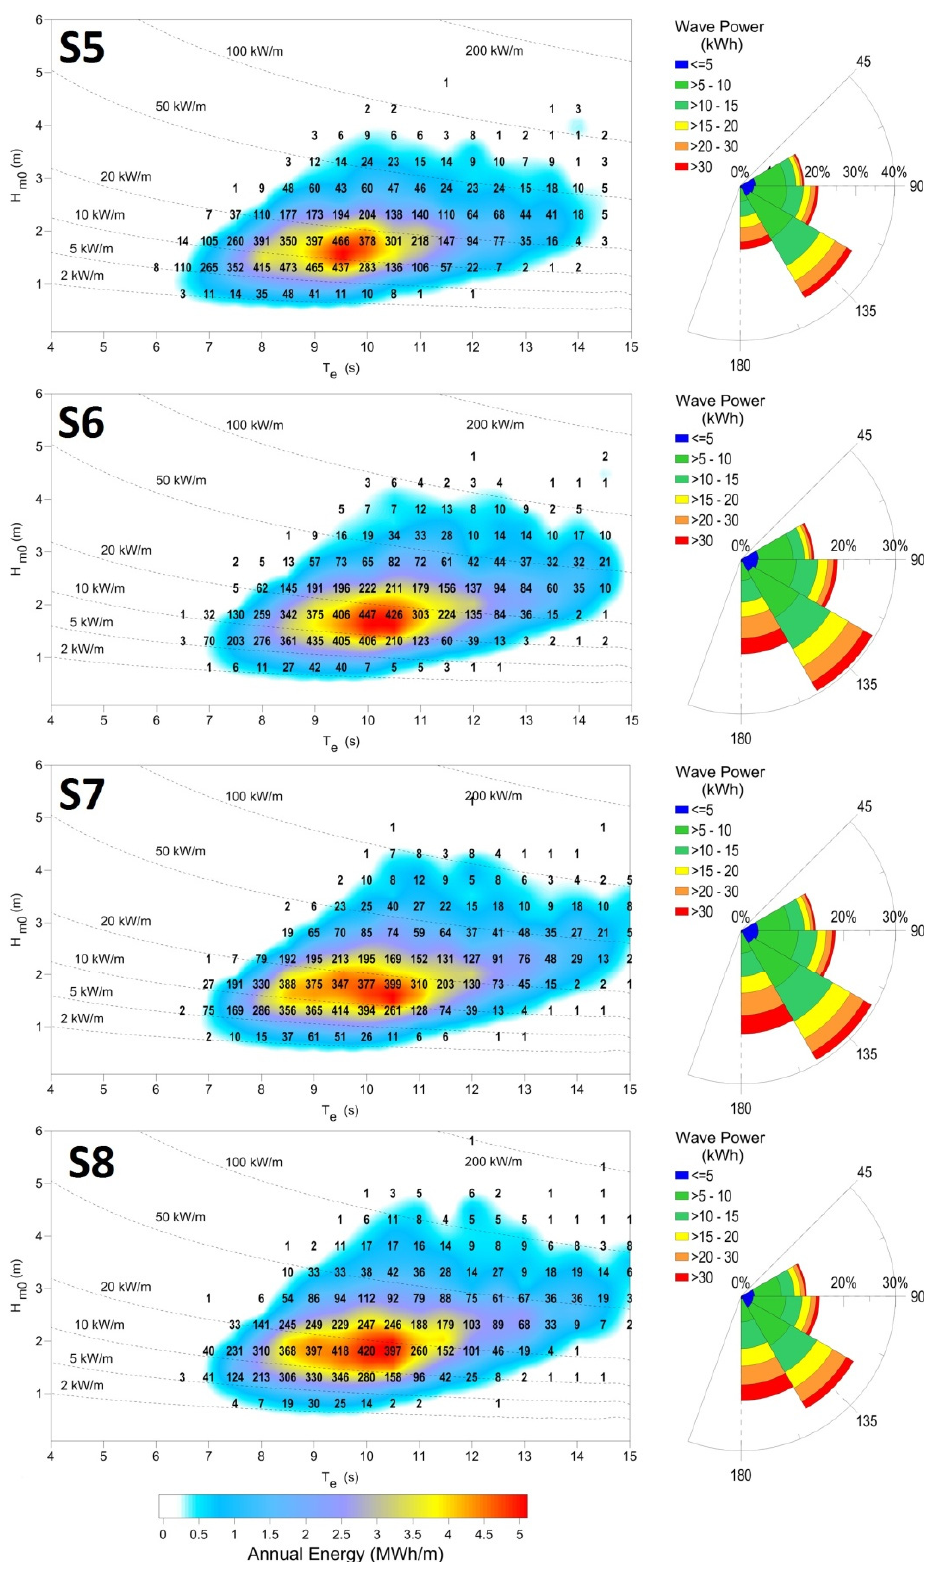
Figure 13. Characterization of the yearly average wave energy points S5, S6, S7, S8 in terms of significant wave height (H m0 ) and energy period (T e ). The color scale represents annual energy per meter of wave front (in MWh/m). The numbers within the graph indicate the occurrence of sea states (in number of hours per year) and the isolines refer to wave power.